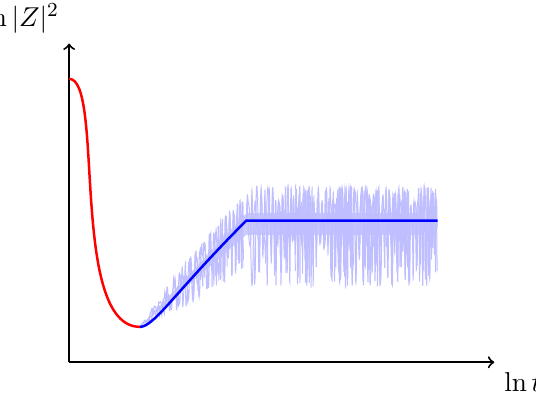
Figure 2 . The genus-2 form factor as a function of time. After an initial decay, the signal displays a ramp and plateau at sufficiently late times. The ramp and the plateau are the average of the noisy signal. The σ -model captures the moments of this noisy